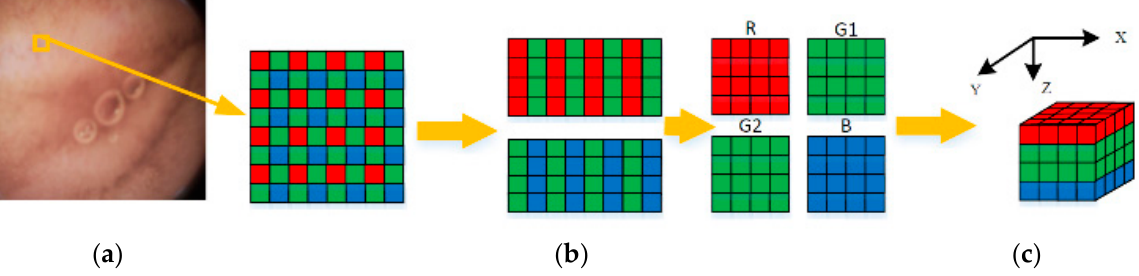
Figure 4. Construction of 3D blocks ( a ) Raw Bayer pattern ( b ) Regrouped color components ( c ) 3D blocks